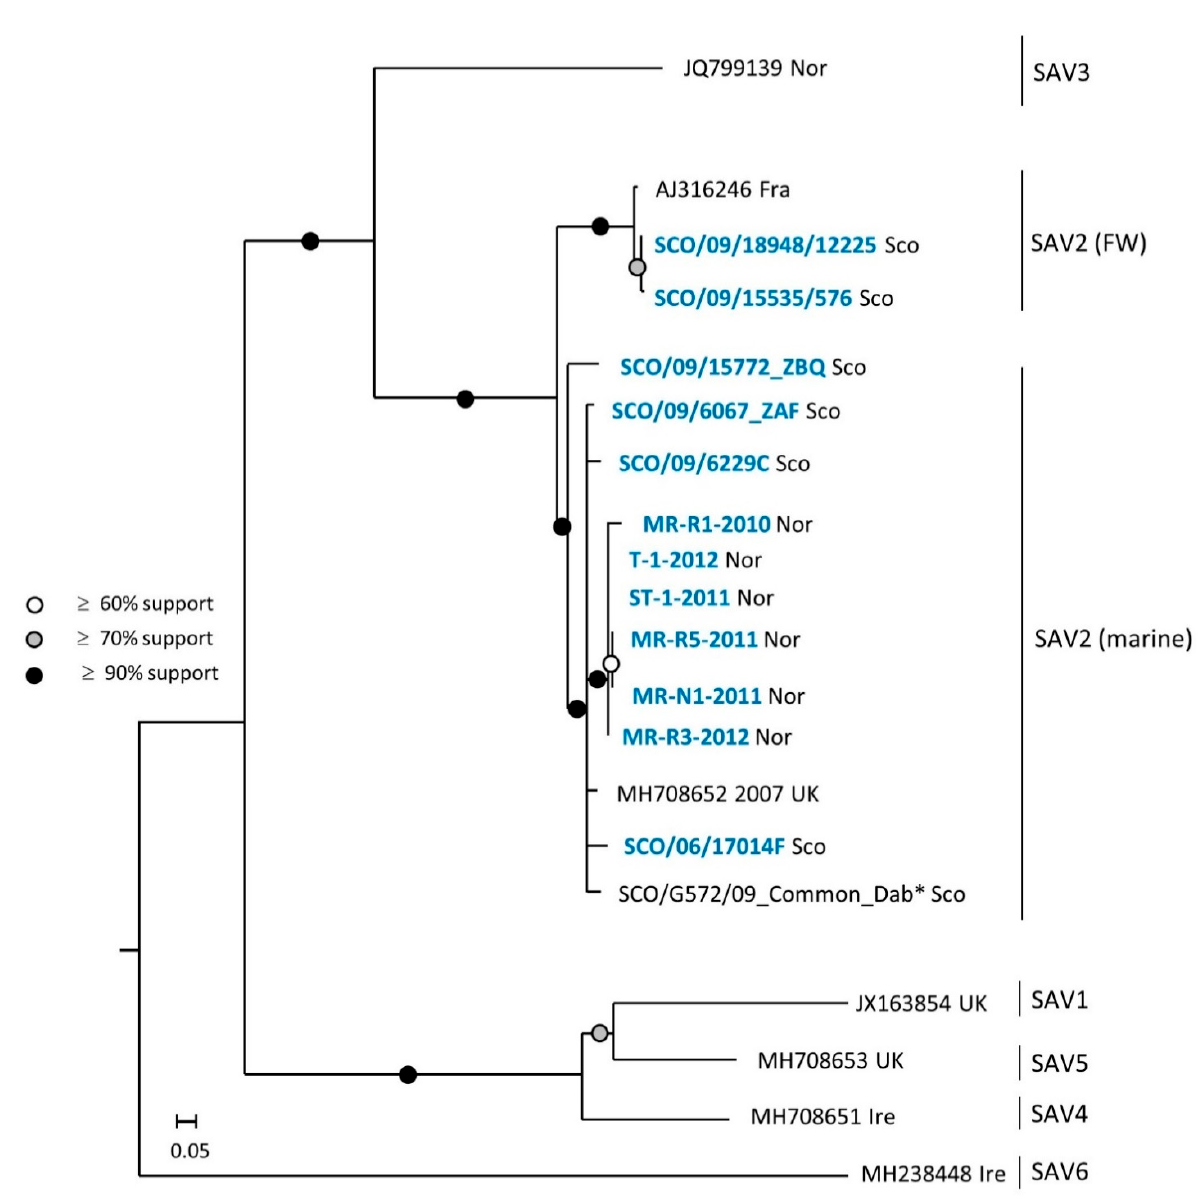
Figure 4. Maximum likelihood trees of a 1760 nt fragment covering the nsp3 gene to identify the relationship between Norwegian and Scottish SAV2. Twelve new SAV2 nsp3 generated in the present study (in blue) are included together with SAV1–6 nsp3 sequences obtained from GenBank (referred to by the accession number) and SAV2 nsp3 sequences from common dab from Supplementary Material, Dataset S1 presented by Gallagher et al. [11], marked with (*). Country/geographic area of origin is marked by a suffix at the end of each sequence. To improve the graphical visualization, only selected sequences from the FW SAV2 subgroup are shown. The analysis was also performed including the three FW SAV2 sequences from the full genome dataset in Figure 3 with identical results.